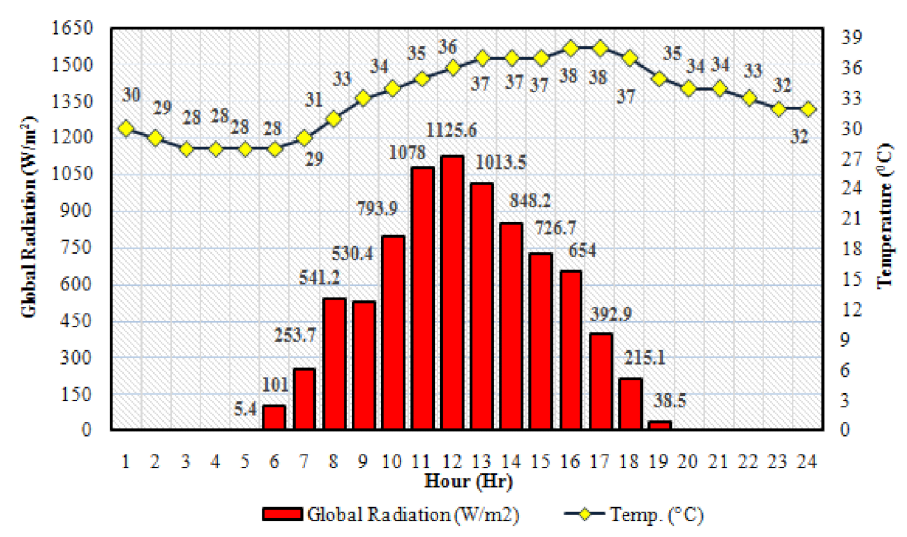
Figure 5. Solar PV data of Temperature ( ◦ C) and Radiation (W/m 2